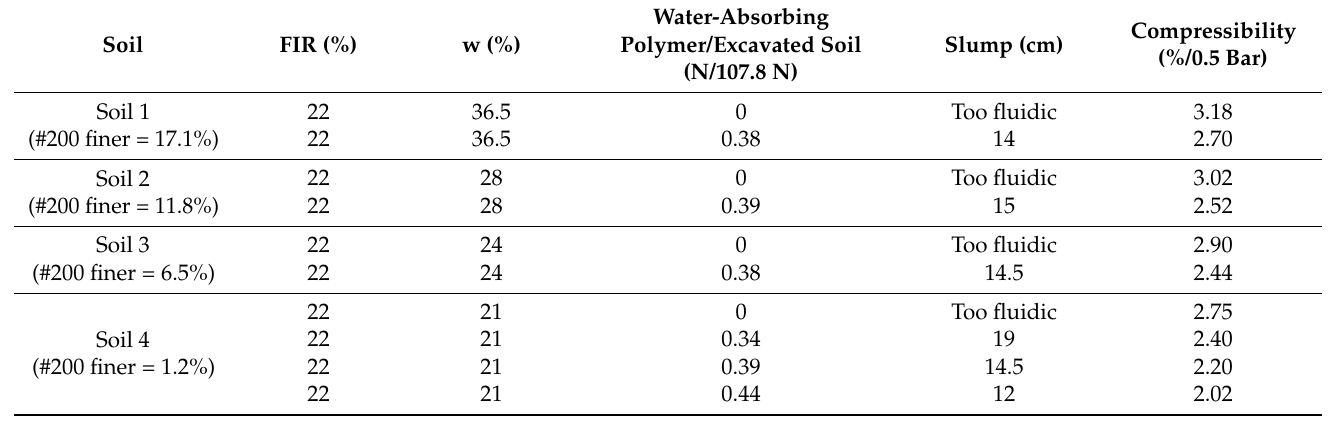
Table 4. Properties of conditioned soils depending on added amount of water-absorbing polymer.